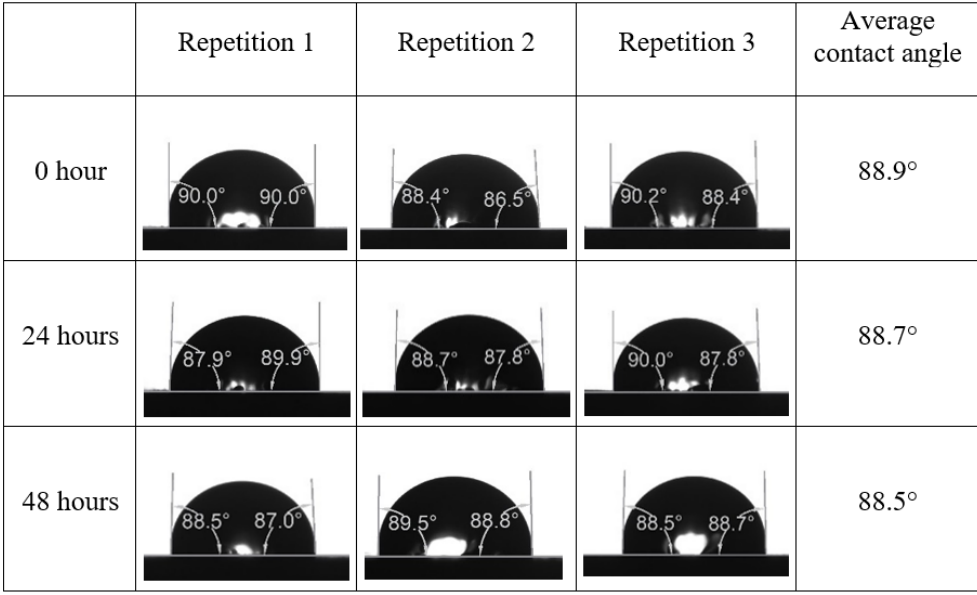
Figure A25. Dynamic Contact Angle Measurement Results for 75% Na 2 SO 4 + 25% NaCl (3500